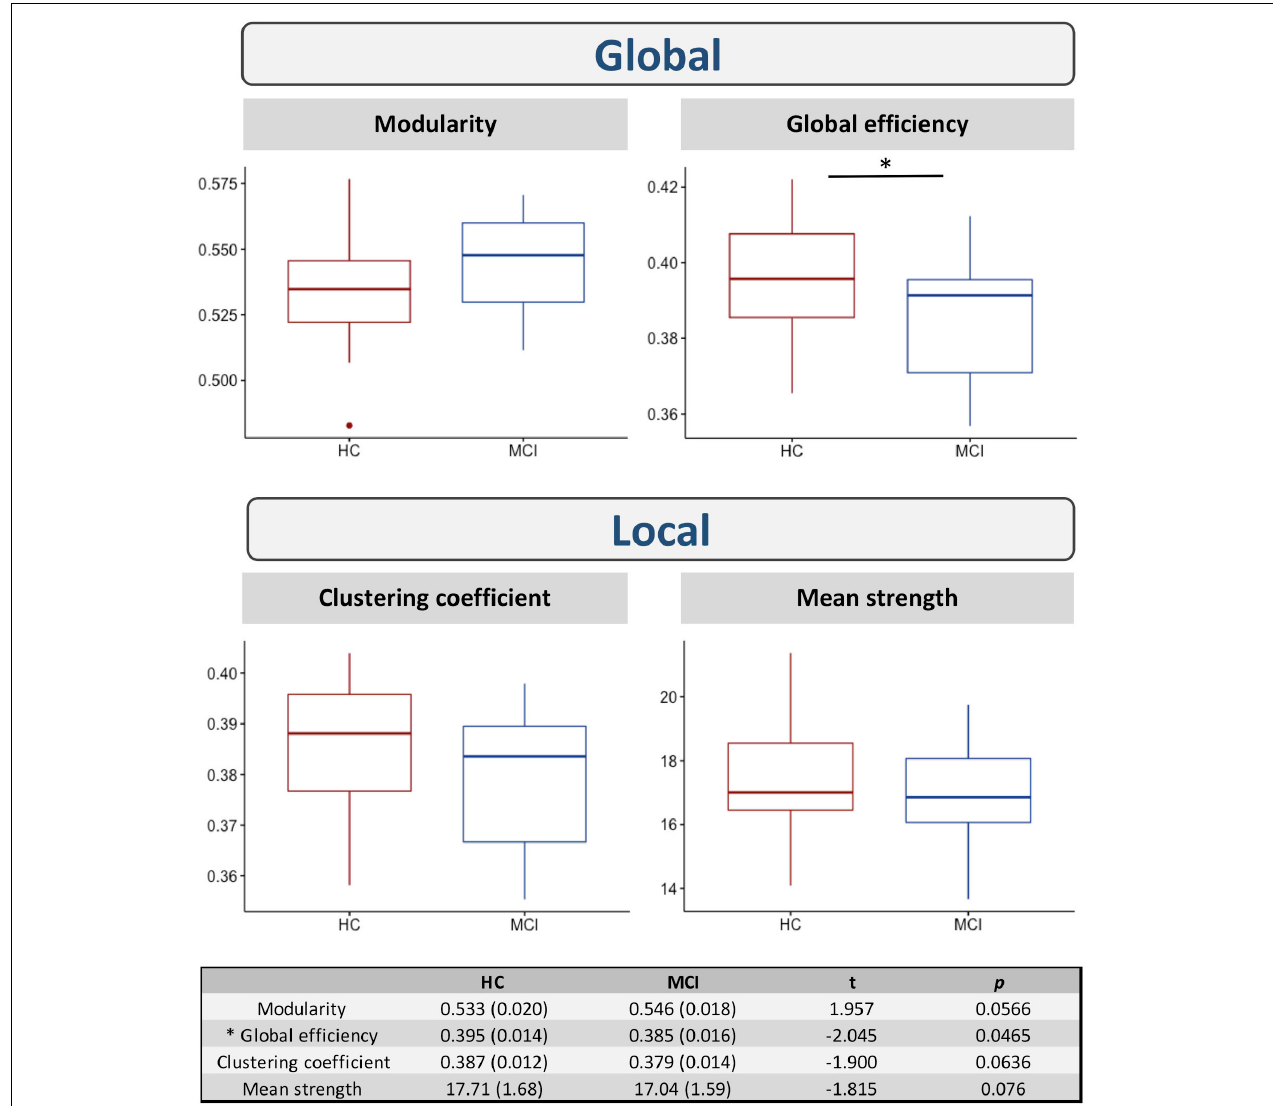
FIGURE 3 | Differences in network measures between HC and MCI. ∗ indicates significant differences between the two groups at p(uncorrected) <